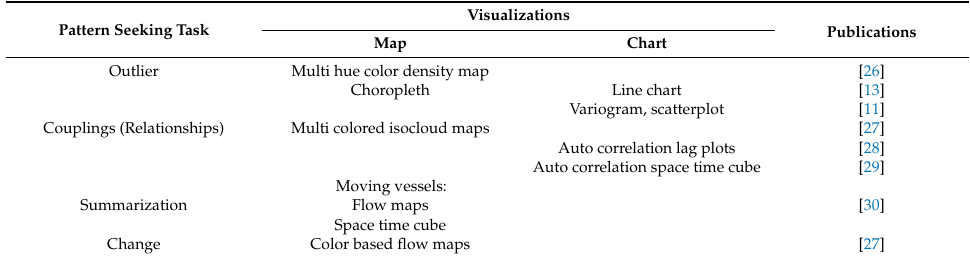
An overview of the review of visualizations for pattern seeking analytic tasks for spatio-temporal